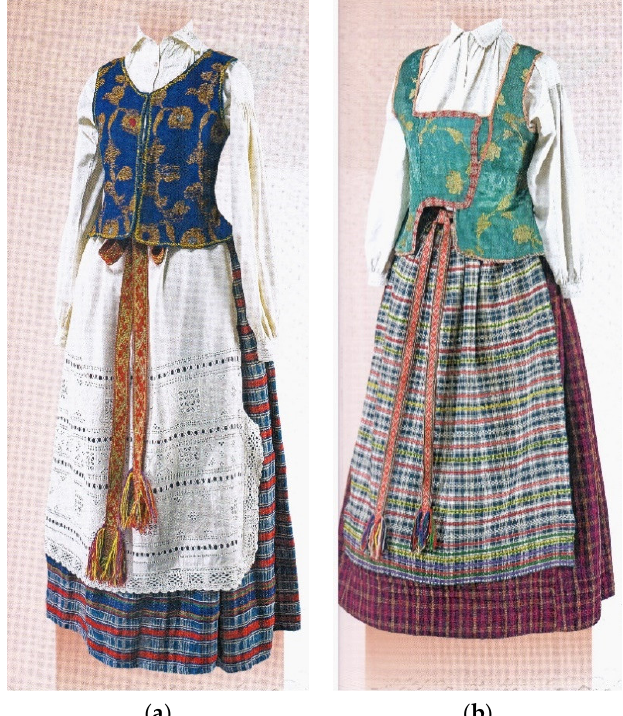
Figure 17. Folk costumes from Dzūkija: ( a ) From Kaišiadorys district, the 19th century: Skirt A. and A. Tamošaitis gallery, Nr. 878; shirt LDM LD-300; apron LDM LA-1442; vest ČDM E-4009; sash LDM LA-2272; ( b ) from Prienai district, the second half of the 19th century: Skirt LDM LA-2119; shirt LDM LA-2134; apron LDM LA-415; vest ČDM E-1618; sash LDM LA-2178.